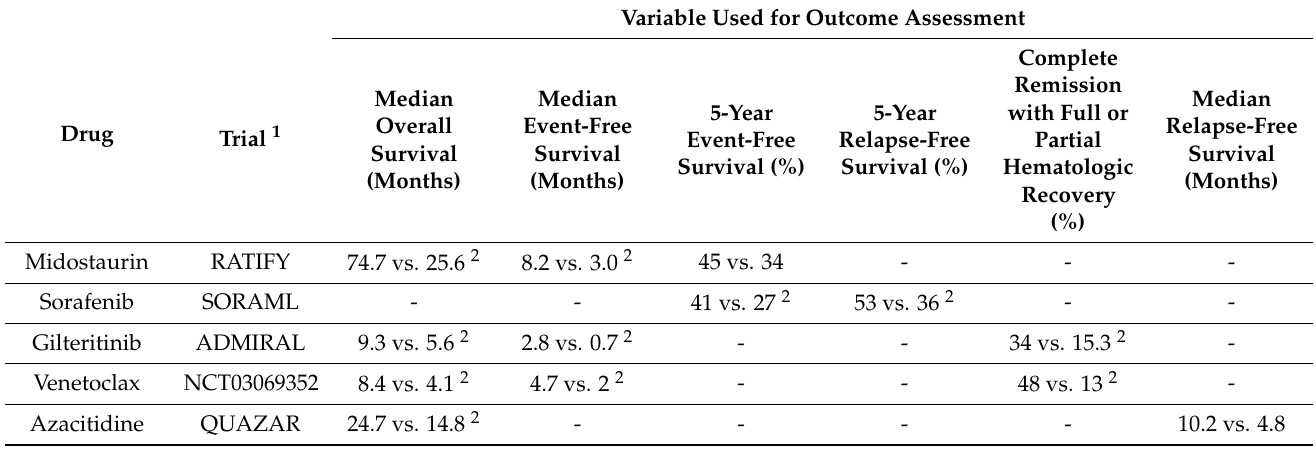
Table A2. Outcomes of the phase III clinical trials of novel methods of AML